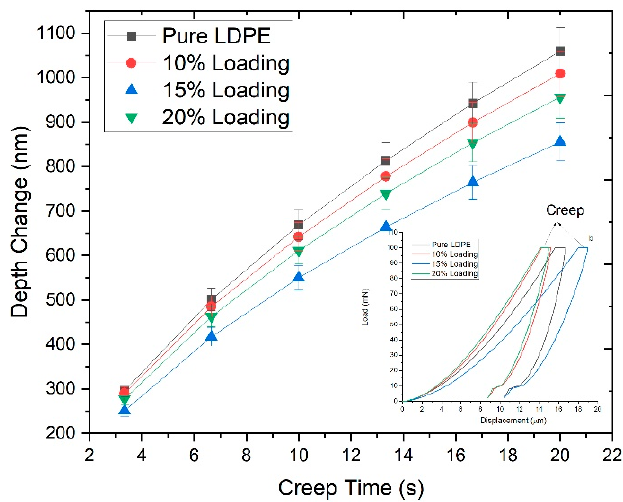
Figure 7. Depth change vs. holding time of pure LDPE sheet and the biocomposites reinforced with ChCl pretreated RHW loadings (10, 15, and 20 wt.%) at peak load of 100 mN for 20